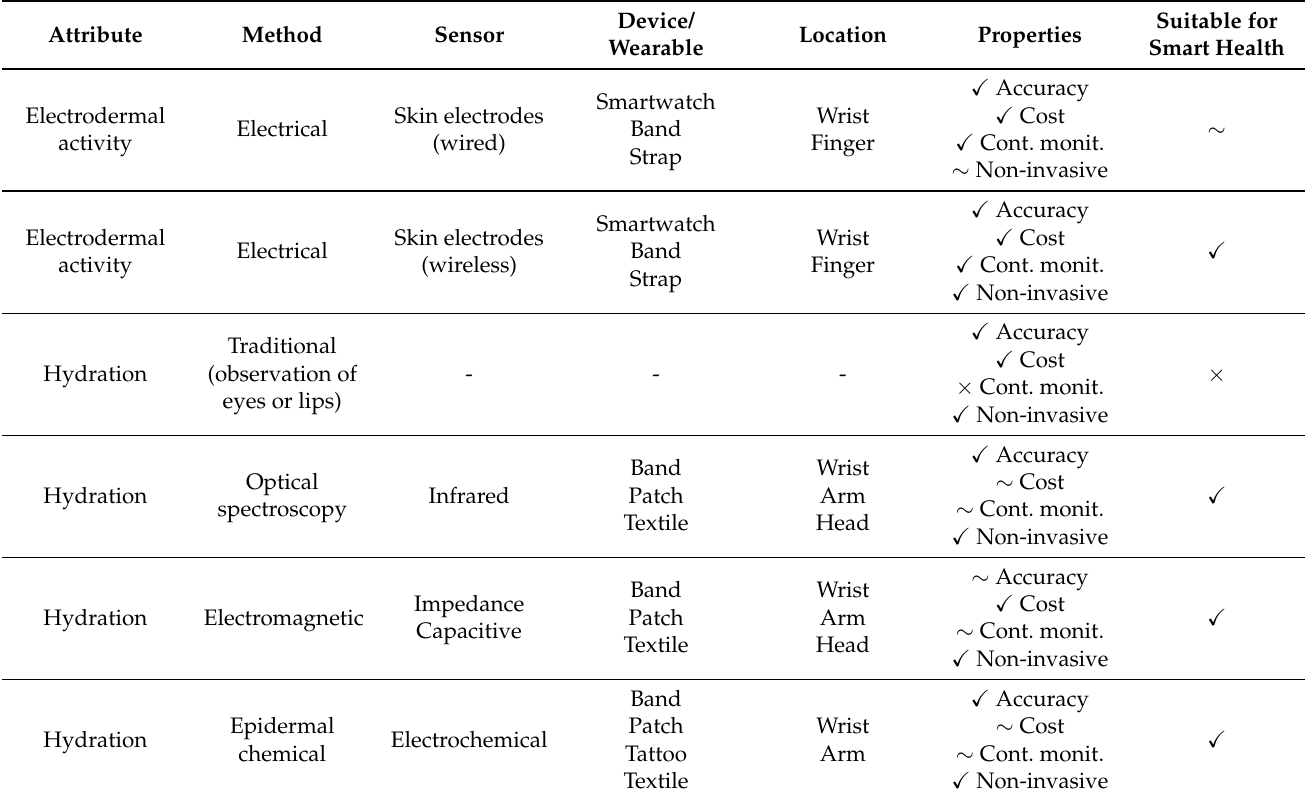
Table 6. Characteristics of the methods for electrodermal activity sensing and hydration